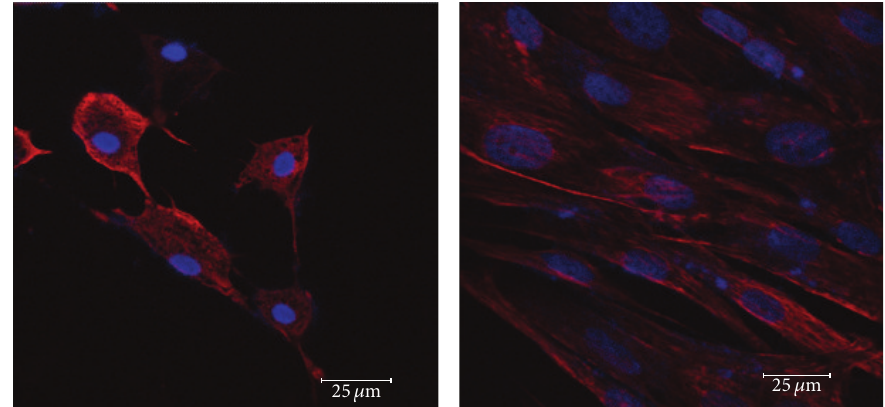
Figure8:ExpressionofvimentininundifferentiatedanddifferentiatedhighpassagedeBM-MSCs.Confocalmicroscopyshowstheexpression of vimentin (red) in neural crest-like cells from eBM-MSCs of middle-aged horse after 12 h of chemical induction. DAPI was used to stain the nuclei (blue). Undifferentiated control eBM-MSCs are in the right panel. Note the diffuse localization of vimentin, which is expressed in undifferentiated and in neural progenitor cells. Scale bar = 25 𝜇 m.